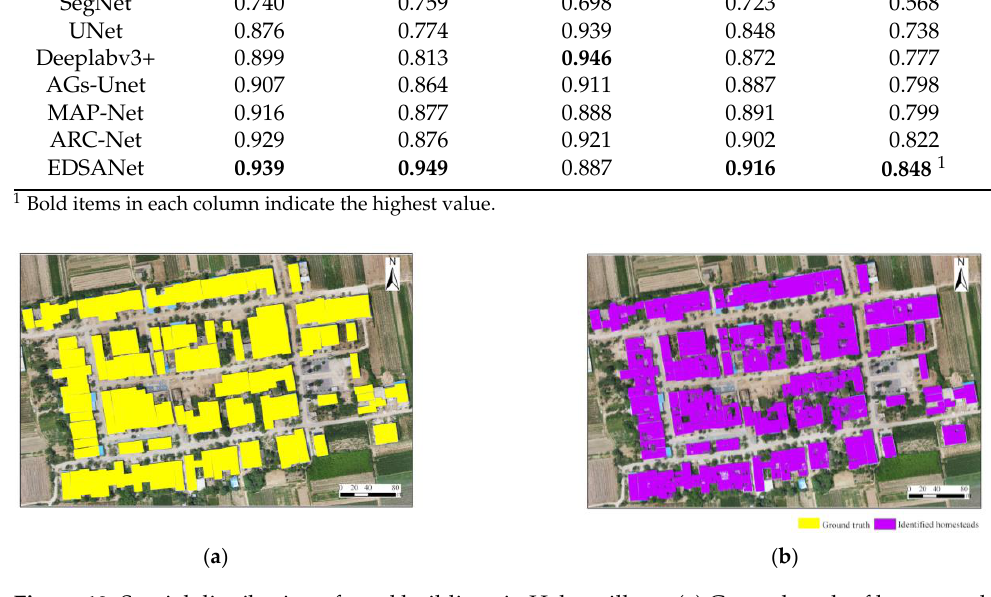
Table 3. Building extraction results with rural Weinan building dataset using different CNN models.